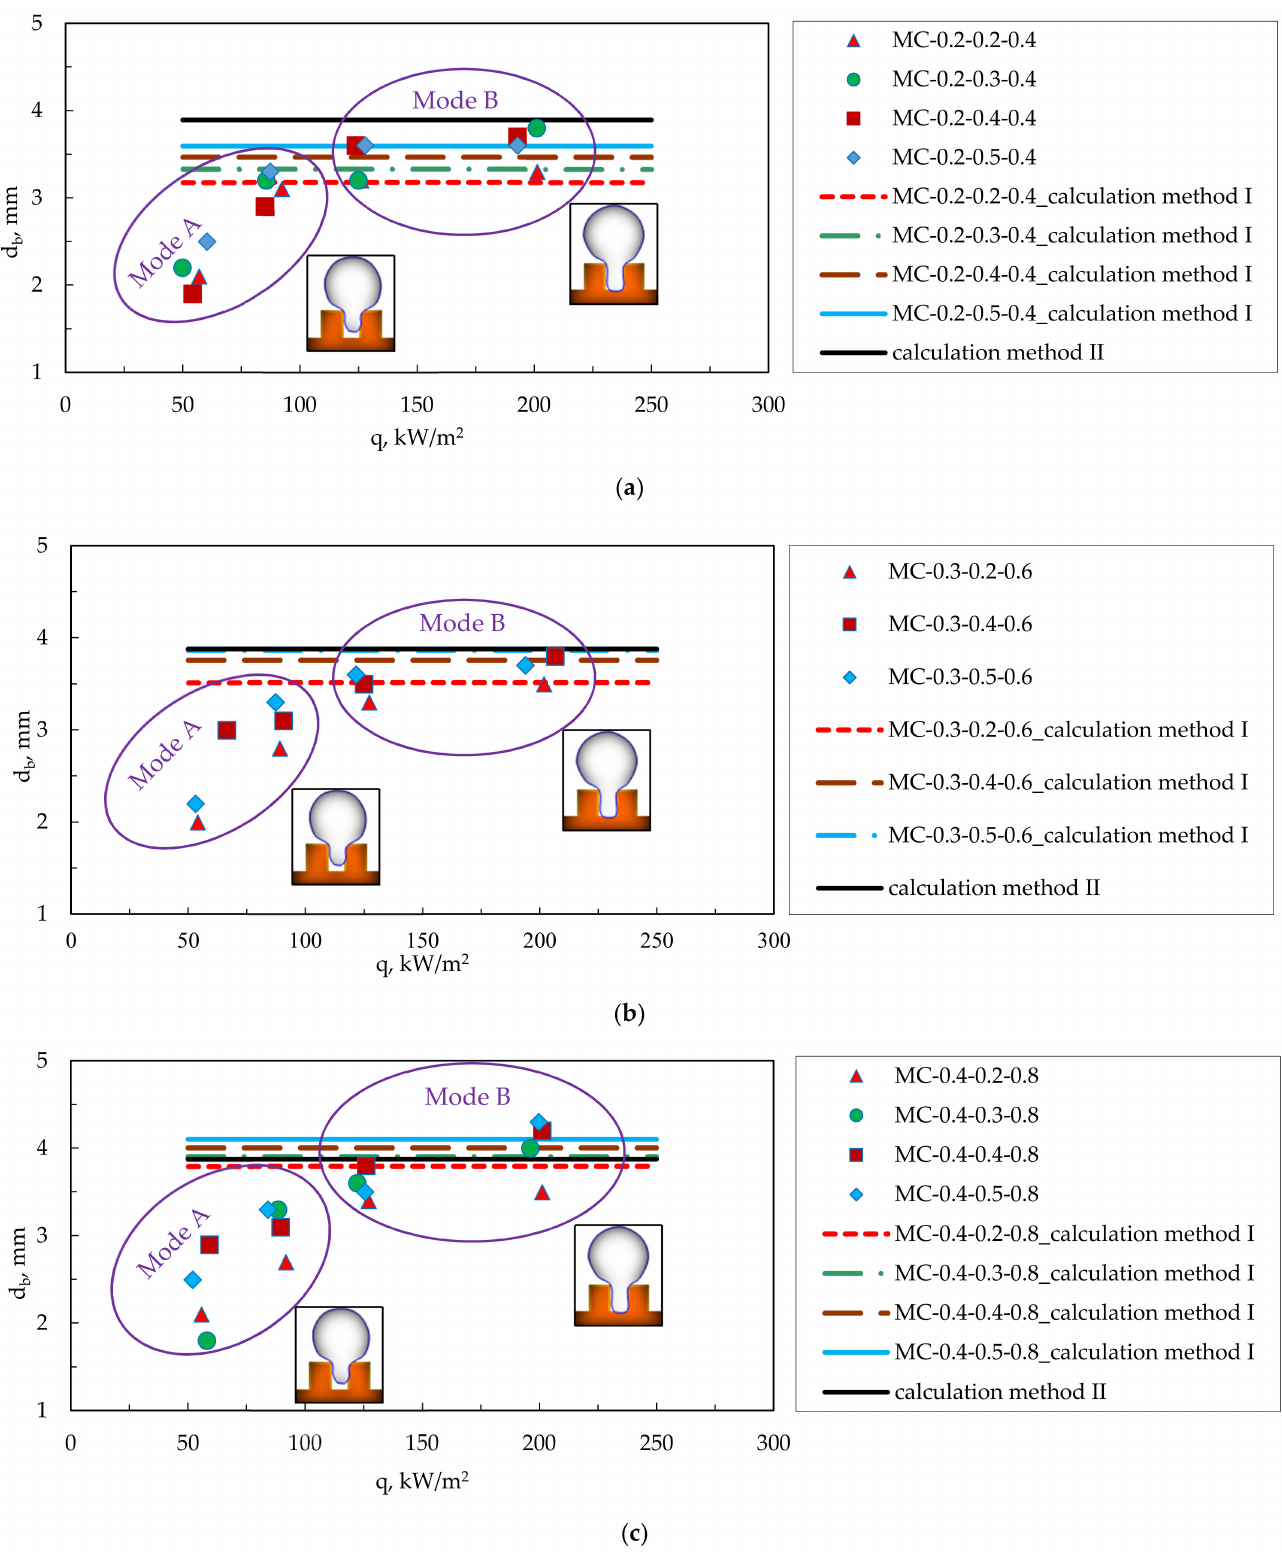
Figure 16. Comparison of measured and predicted bubble departure diameters for microchannels: ( a ) 0.2 mm wide; ( b ) 0.3 mm wide; ( c ) 0.4 mm